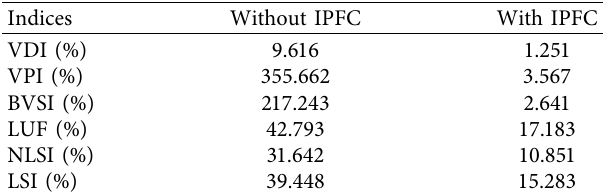
Table 11: Overall severity indices comparison for an N-1 con- tingency case.